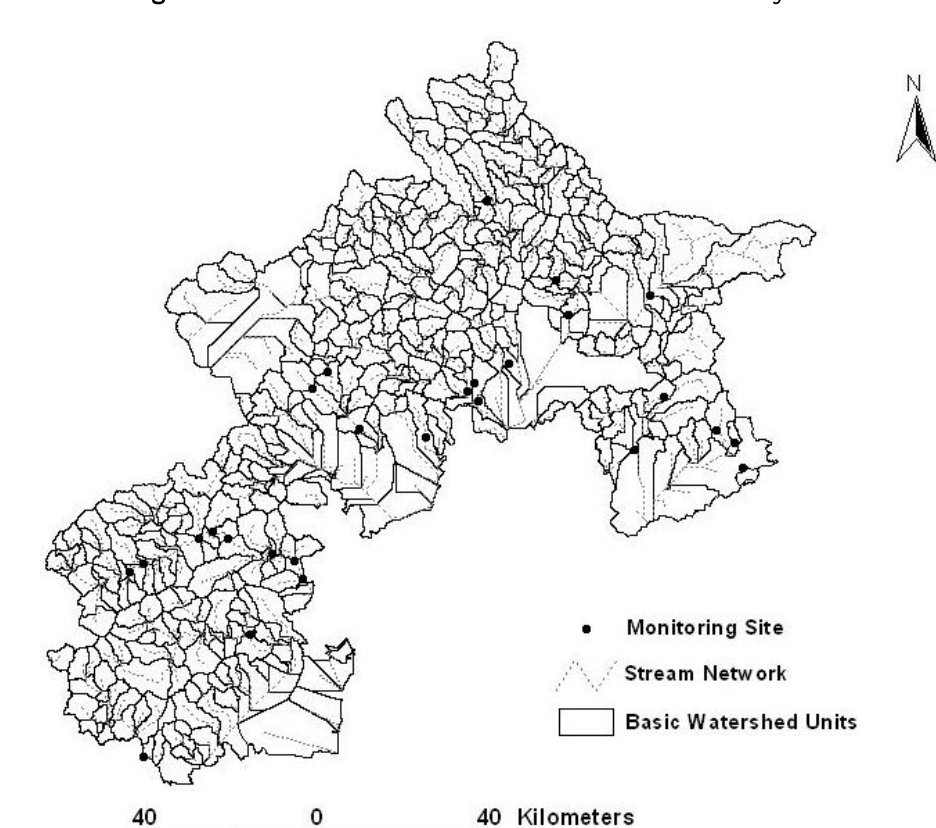
Figure 3. Basic watershed units delineated in the study